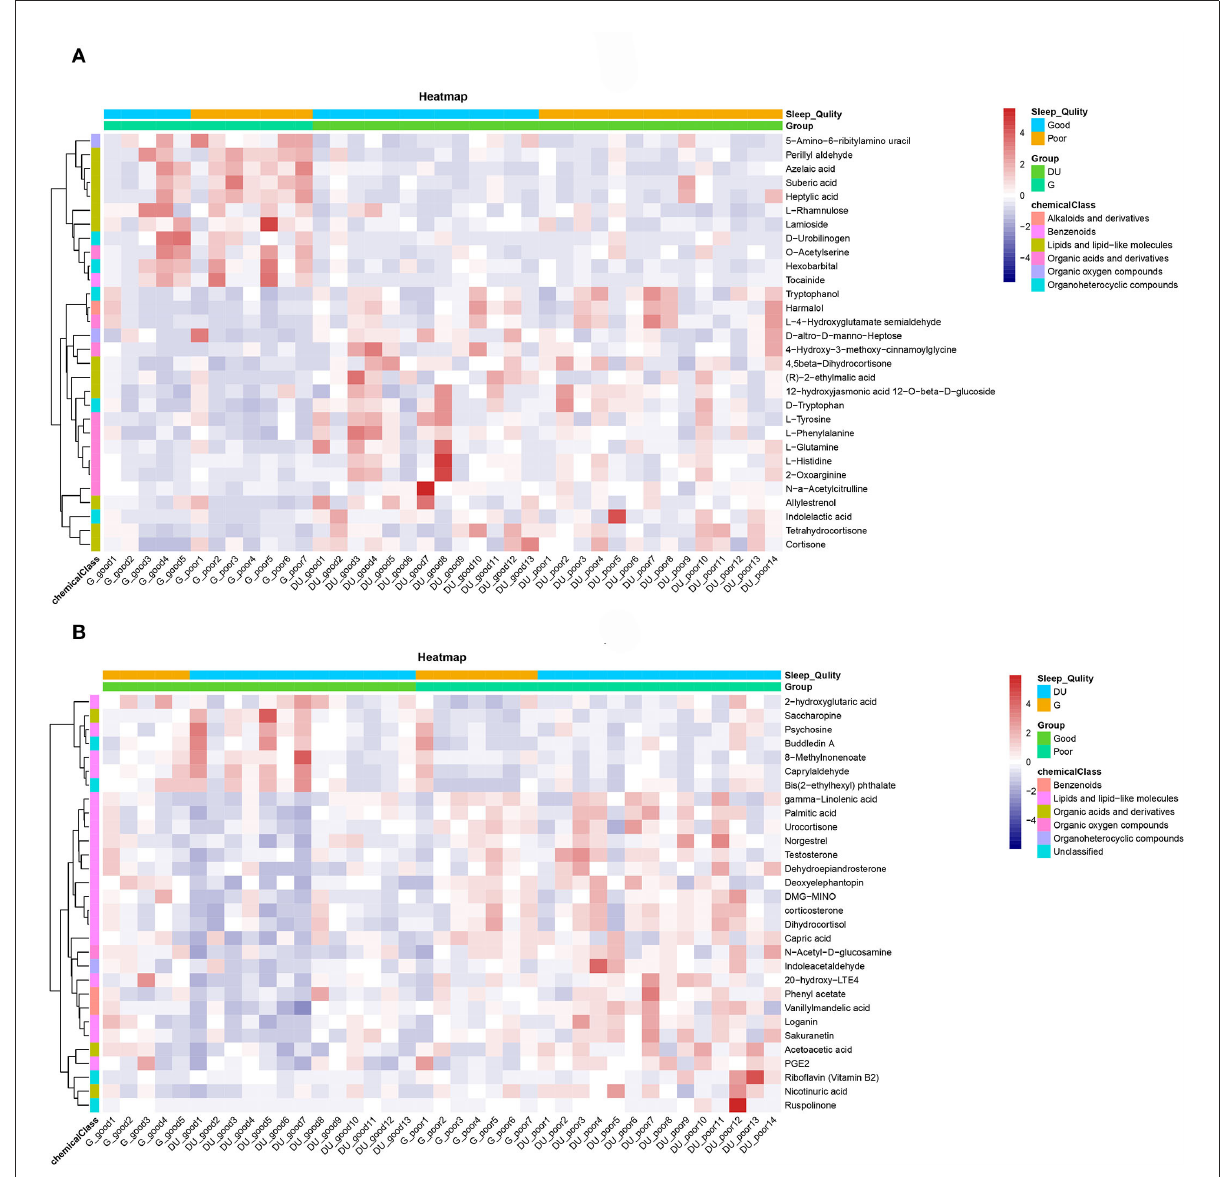
FIGURE4 (A) Heatmap of the environmental factor group (DUvsG), and DUvsG refers to the group “Deep-underground vs. ground”; (B) Heatmap of the sleep quality group (GSQvsPSQ), and GSQvsPSQ refers to the group “Good sleep quality vs. poor sleep quality.” The abscissa represents the sample name, and the ordinate represents the differential metabolite. The color from blue to red signifies the expression abundance of metabolites from low to high, specifically, the redder indicats the higher expression abundance of differential metabolites. At the same time, information about different groups (deep-underground vs. ground, and good sleep quality vs. poor sleep quality) is labeled at the